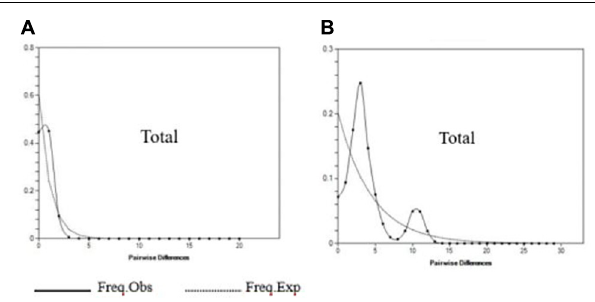
FIGURE 6 | Nucleotide mismatch distribution in G. przewalskii of all populations for two markers: (A) COI and (B)